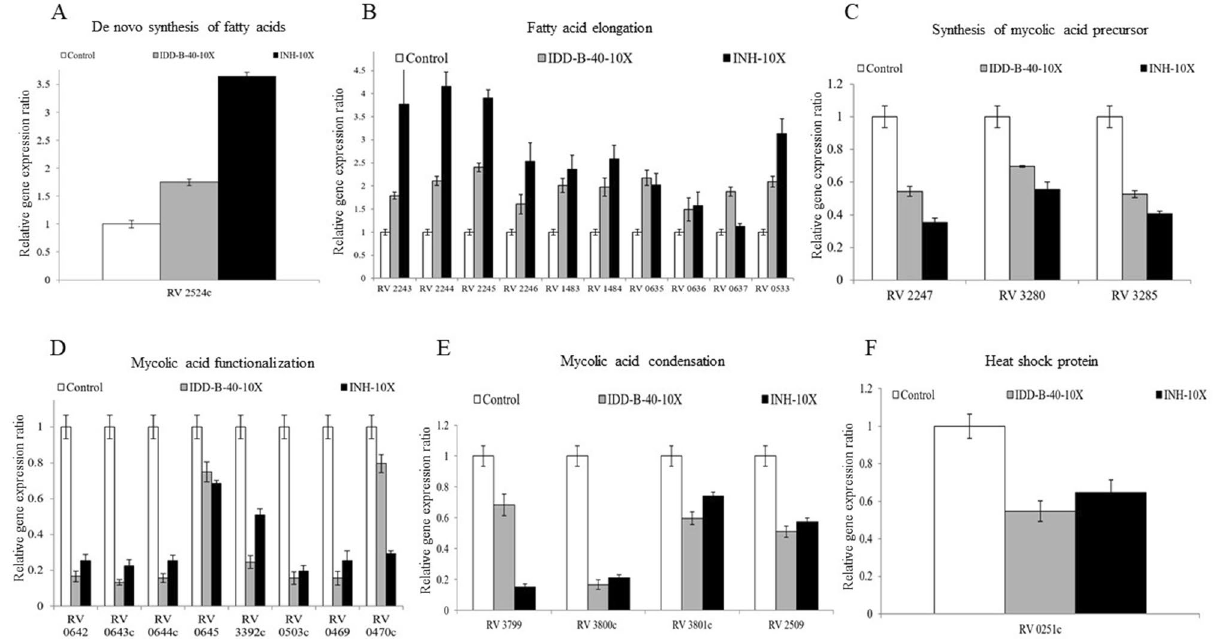
Figure 8. Changes in mRNA levels of M. tuberculosis gene expression ratio involved in ( A – E ) mycolic acid synthesis and ( F ) heat-shock protein during exposure to 10 × IDD-B40 and